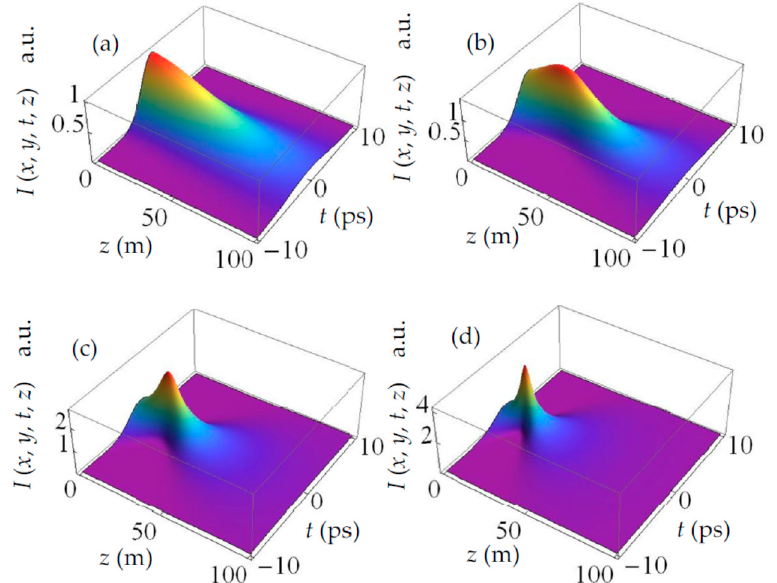
Figure 6. Evolution of spatiotemporal intensity I ( x , y , t , z ) (Equation (20)) of SCTLGSM pulsed beam as a function of propagation distance z and time t with different chirp coefficients ( a ) s = 0, ( b ) s = − 0.4 ps − 2 , ( c ) s = − 0.8 ps − 2 , ( d ) s = − 1.2 ps − 2 and for n = 0, m = 0.